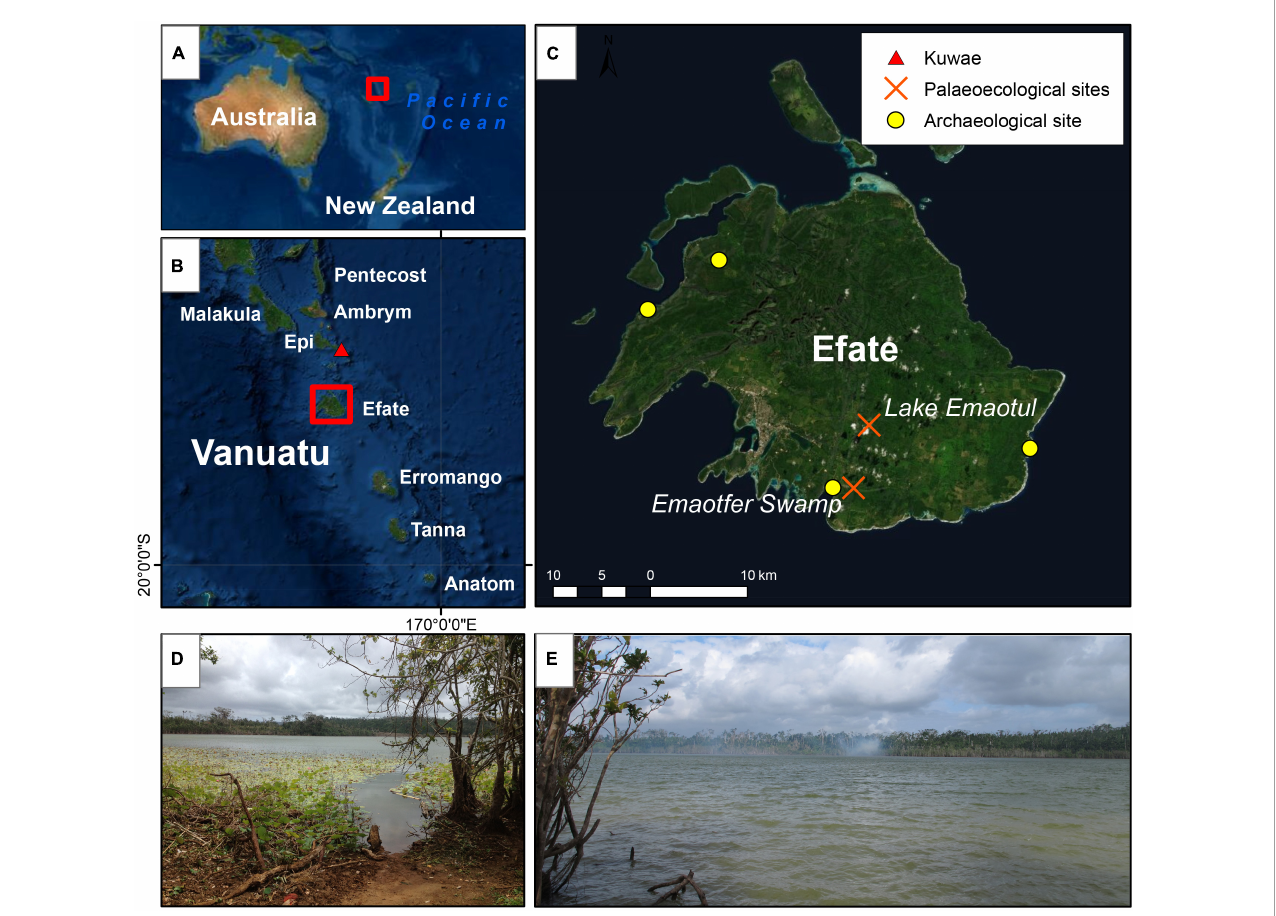
FIGURE1 (A) The location of Vanuatu within the Pacific Ocean; (B) the Southern and central islands of Vanuatu, the red triangle indicates the location of the Kuwae submarine caldera; (C) the island of Efate. Yellow circles indicate the location of archaeological sites and the red crosses indicate palaeoecological